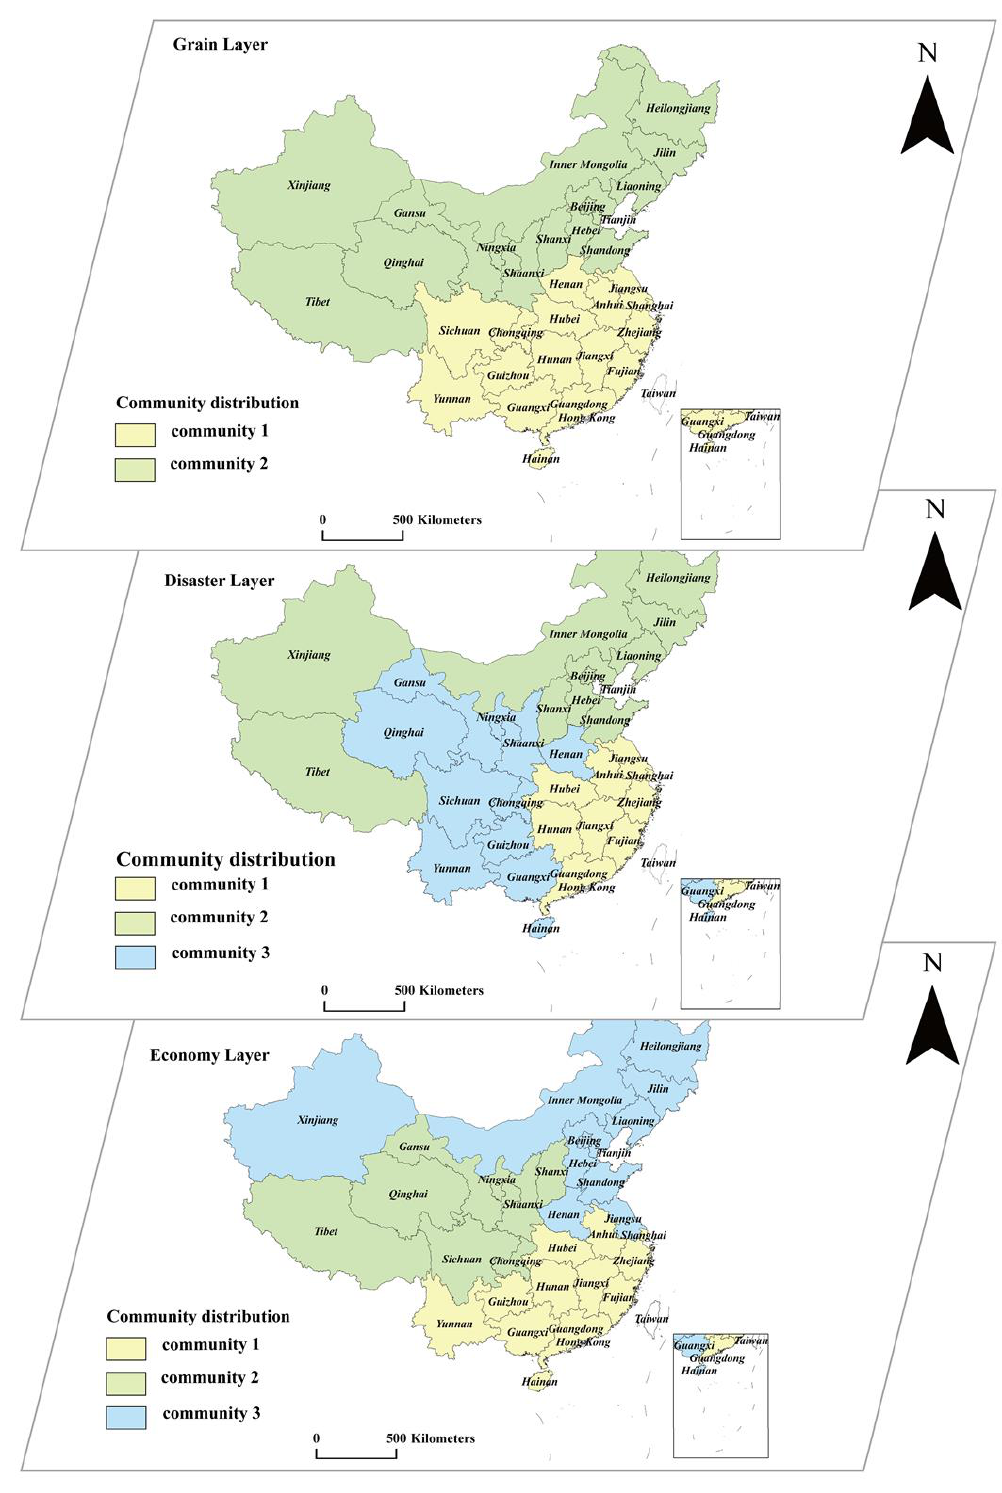
Figure 11. Community cluster of grain–disaster–economy multilayer network in